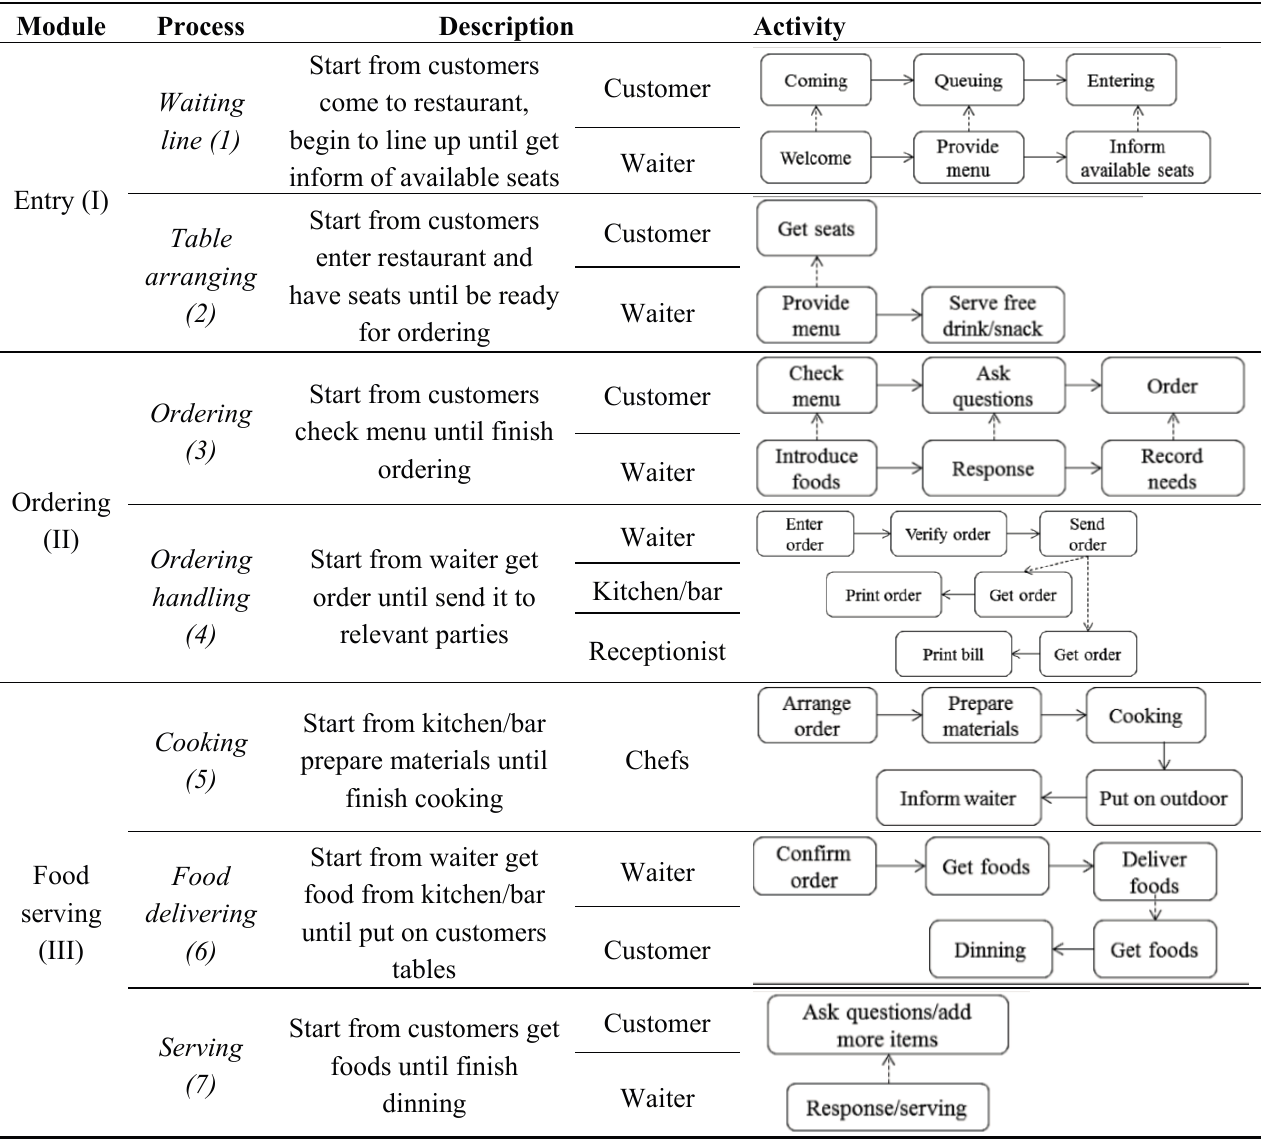
Table 3. The existing